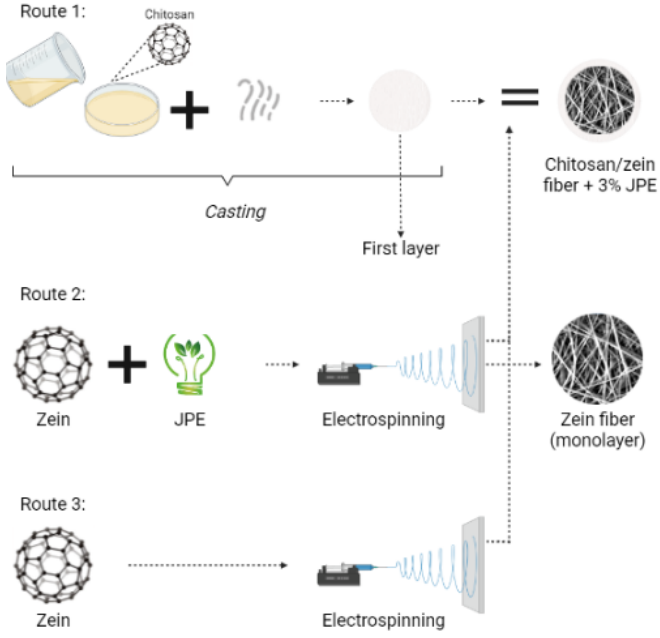
Figure 1. Scheme of the experimental procedure to obtain the bilayer and monolayer films.